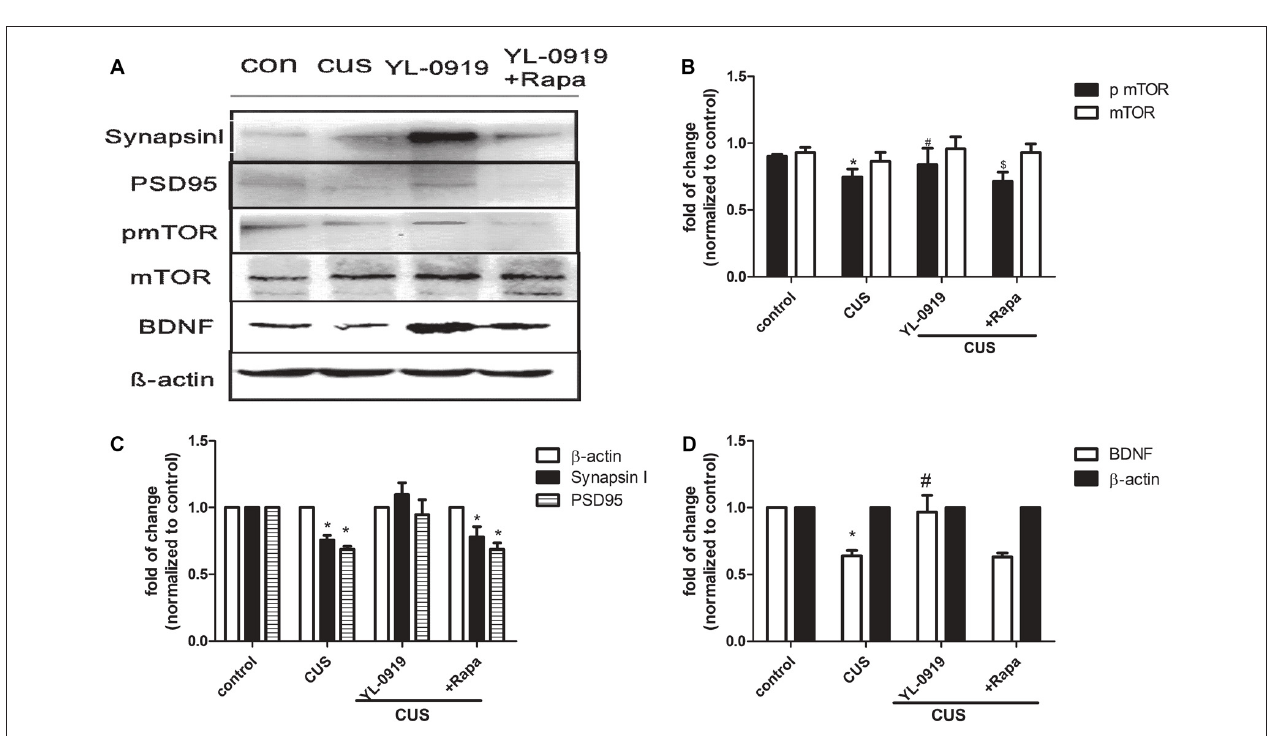
FIGURE 4 | Hippocampal proteins expression of synapsin I, postsynaptic density protein 95 (PSD95), phosphorylated mammalian targeting of rapamycin (pmTOR), mTOR and and brain-derived neurotrophic factor (BDNF) in CUS-induced depressive-like rats treated with YL-0919 and/or rapamycin for 14 days. Rats were exposed to CUS and infused on day 21 with vehicle or rapamycin (0.2 nmol in DMSO, i.c.v.) 1 h before YL-0919 (2.5 mg/kg, i.g.) or vehicle treatment for 14 days. (A) The representative images of proteins levels of synapsin I, PSD95, pmTOR, mTOR and BDNF were determined by western blots are shown. (B) Levels of synapsin I and PSD95 were quantified with β -actin. (C) Levels of pmTOR were quantified with mTOR. (D) Levels of BDNF were quantified with β -actin. Results were quantified and are the mean ± SEM, percent of control ( n = 4 animals; ∗ ,#,$ P < 0.05, two way ANOVAs followed Tukey’s post hoc test).